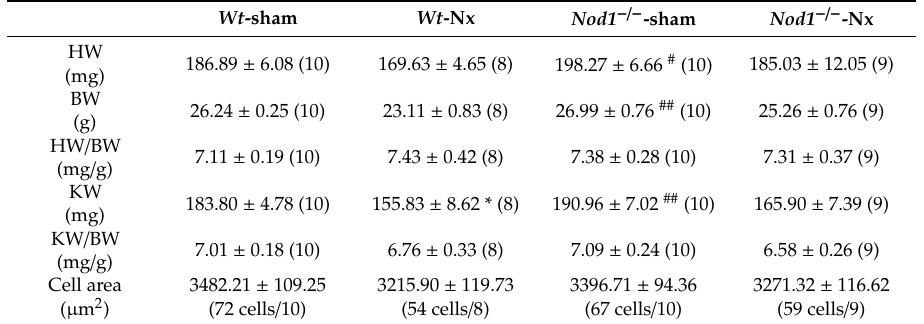
Table 1. Macroscopic parameters in Wild-type ( Wt ) and Nod1 − / − mice subjected or not to experimental chronic kidney disease